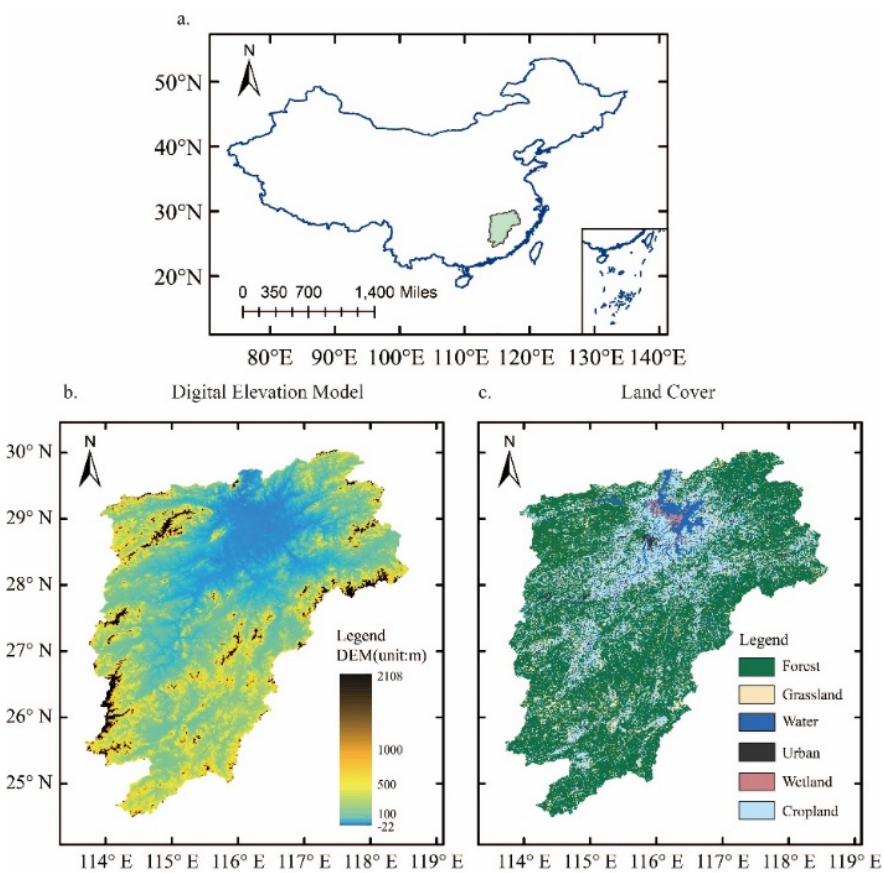
Figure 1. The study area, the DEM (Digital Elevation Model), and land cover of the Poyang Lake basin, showing altitude and land cover classes. ( a ) The Poyang Lake basin; ( b ) The altitude of the Poyang lake basin; ( c ) The dominant land cover classes.